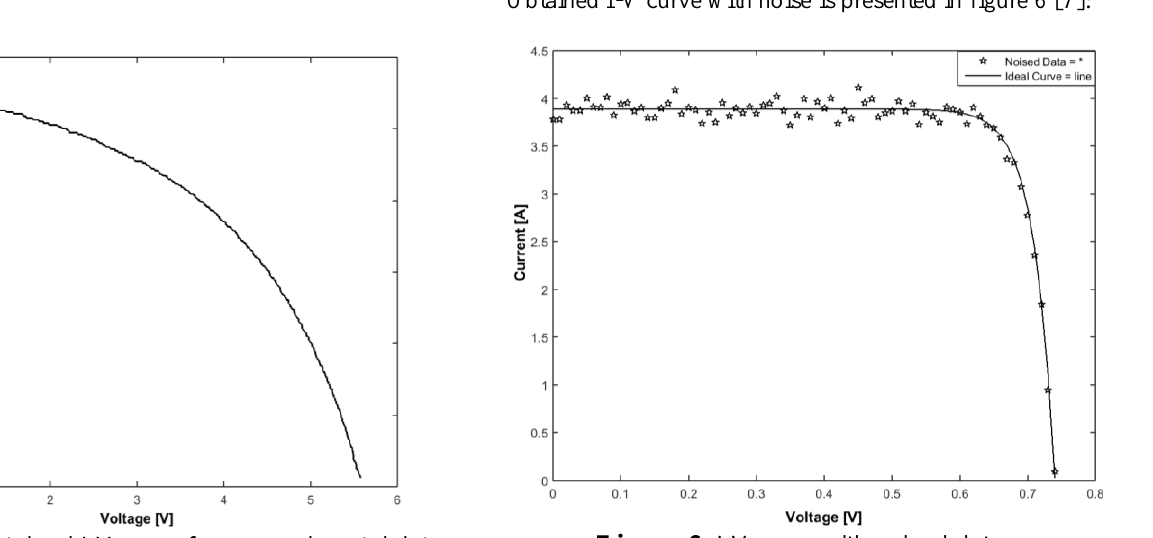
Figure 6 . I-V curve with noised